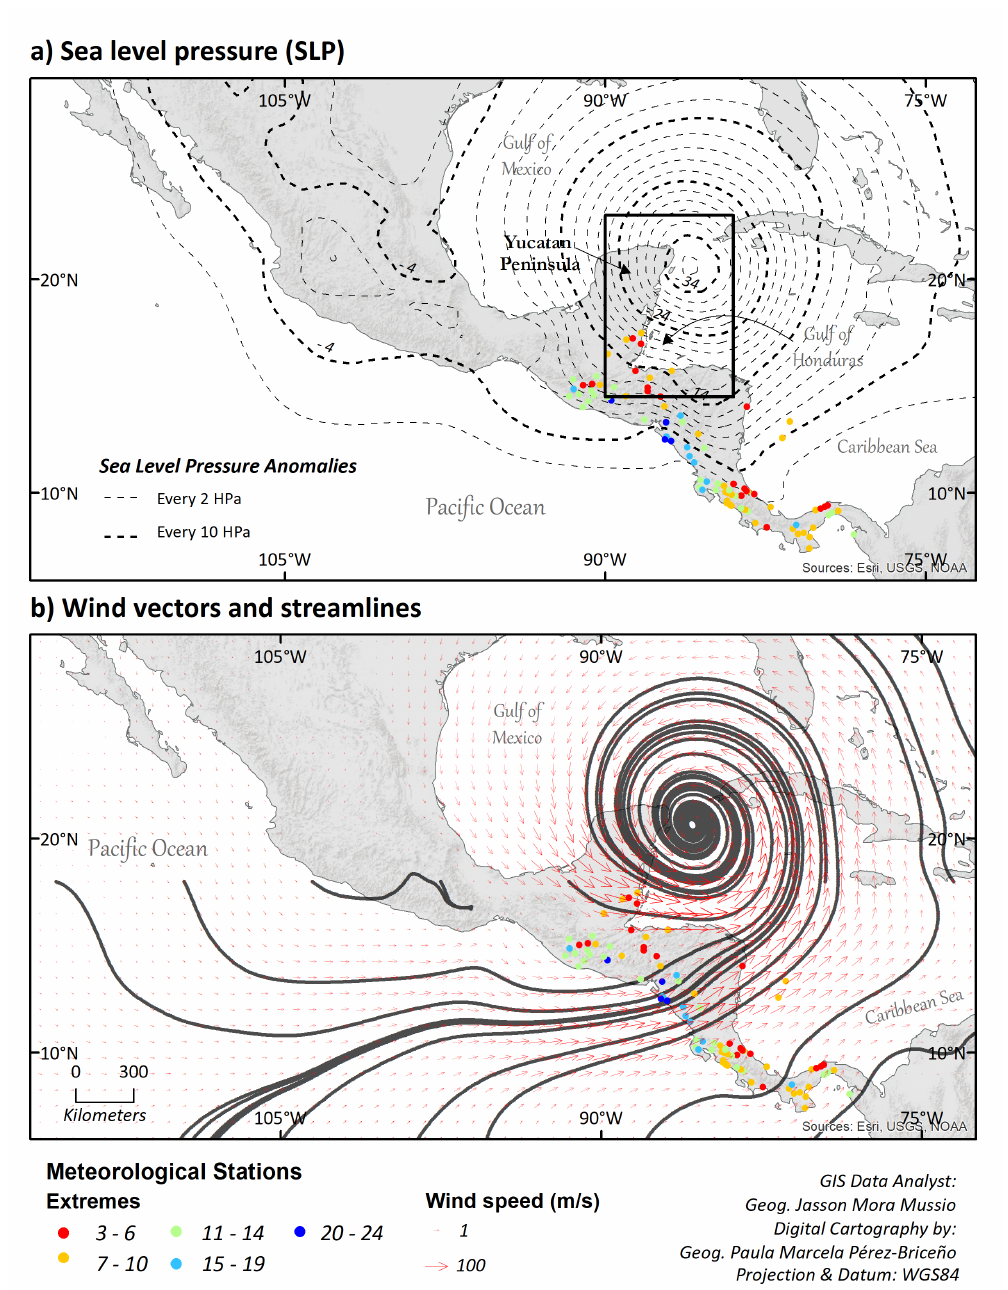
Figure 2. Average anomalies of sea level pressure (SLP) ( a ) and wind vectors with associated streamlines ( b ) during extreme precipitation events in Central America meteorological stations and when the hurricanes occupied the region bounded by 14.5 ◦ N to 23 ◦ N and 84 ◦ W to 90 ◦ W. Cold (warm) colors of the land meteorological precipitation stations denote a large (small) number of registered extreme precipitation events during the period that produces the composite. SLP contours every 2 hPa (thin lines) and every 10 hPa (thick lines). Although the trajectories data cover the period 1970 to 2010, this illustrative figure was constructed using data from 1979 to 2010 due to limitations in the availability of SLP